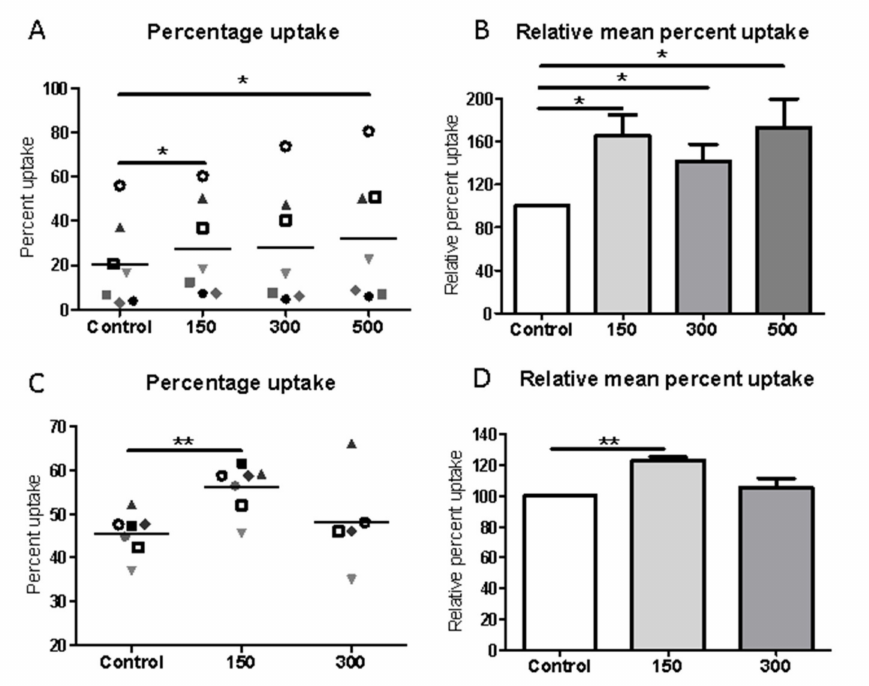
Figure 4. Shockwave stimulation up-regulates macrophage phagocytosis of apoptotic cells. Macrophages were unstimulated (control) or exposed to shockwave intensities of 150–500; 5 Hz, 0.1 mJ/mm 2 then cultured with apoptotic cells for typically 2 h. ( A ) Percentage uptake and ( B ) relative percentage uptake of apoptotic cells by J774 macrophages. ( C ) Percentage uptake and ( D ) relative percentage uptake of apoptotic cells by human monocyte-derived macrophages. Data plotted represent individual values as shown by each symbol with mean value presented ( A , C ) and the normalized data with means ± SEM determining the relative percentage of shock wave exposed cells to control cells for each cell preparation ( B , D ). Data from experiments from 5–7 individual macrophage preparations. * represents p < 0.05; ** represents < 0.001 compared to unstimulated, control